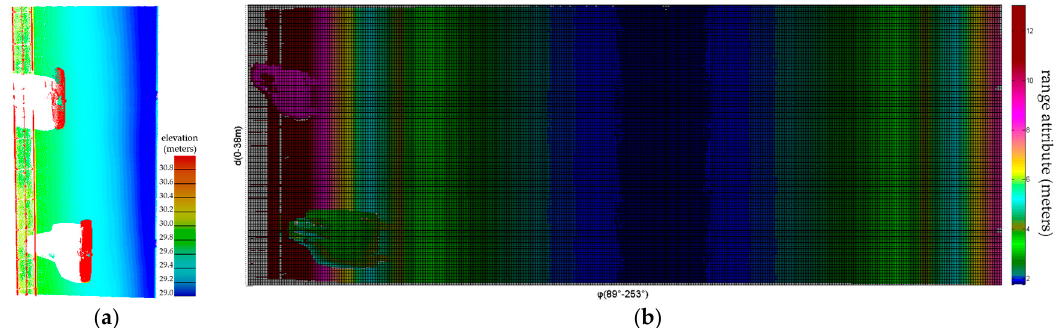
Figure 6. MLS point clouds and the corresponding grid created based on the angular position attribute and the longitudinal distance attribute: ( a ) MLS point clouds colored by elevation (points with low elevation are colored in blue, points with high elevation are colored in red and white areas are those occluded by cars); ( b ) the grid created based on the angular position attribute and the longitudinal distance attribute colored by range attribute (cells with small range attribute are colored in blue, cells with large range attribute are colored in red and empty cells are colored in white).